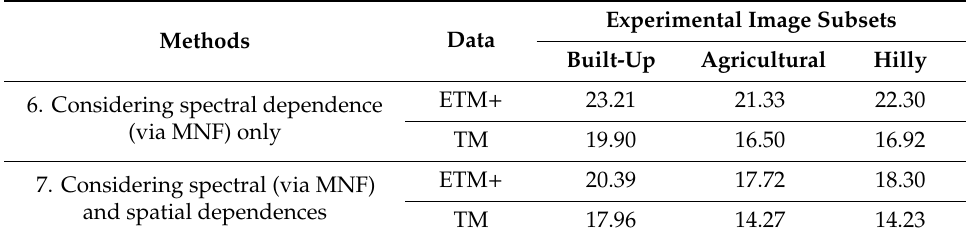
Table 8. Estimates of information content for both ETM + and TM image subsets using MNF-based methods (bits /